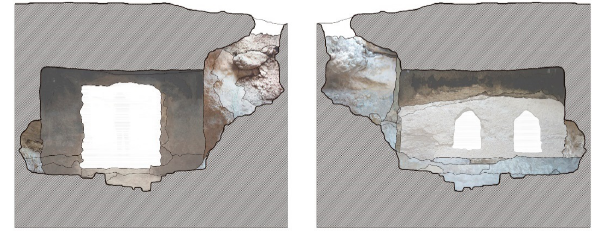
Figure 5. The vestibule: cross-sections of the space.